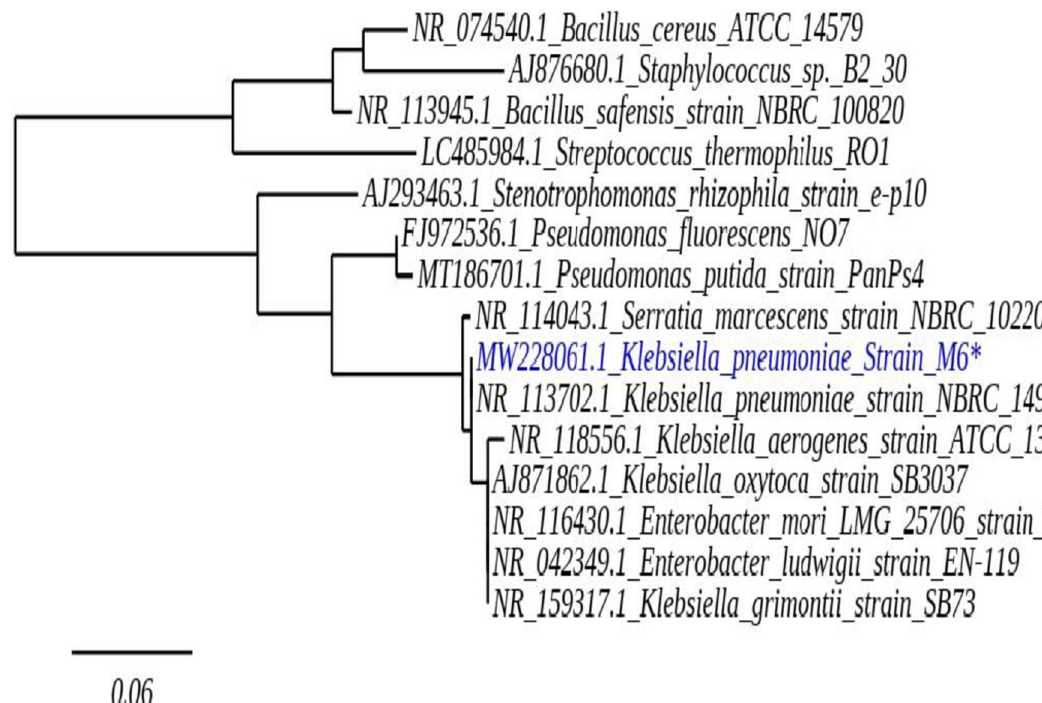
Fig 1. Phylogenetic relationship of strain M6 inferred by neighbor-joining method. Evolutionary analysis was conducted by online tool phylogeny (phylogeny.fr/simple_phylogeny.cgi).